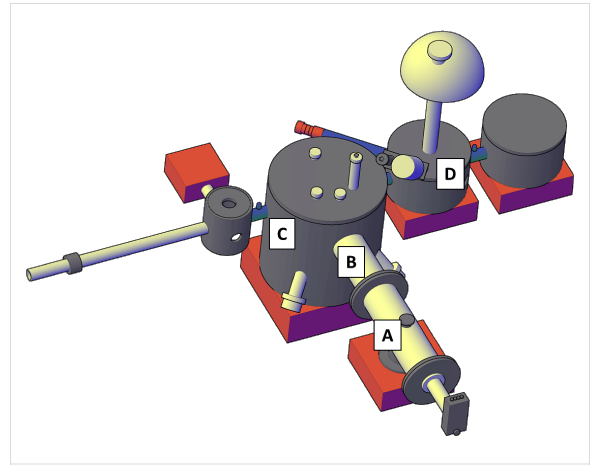
Figure 1: Sketch of the experimental set up: the NPs are created by the NC200 source (A), they are mass selected by the QMF (B) and they are deposited on the substrate in the deposition chamber (C). The chemical characterization is performed in situ in the XPS chamber